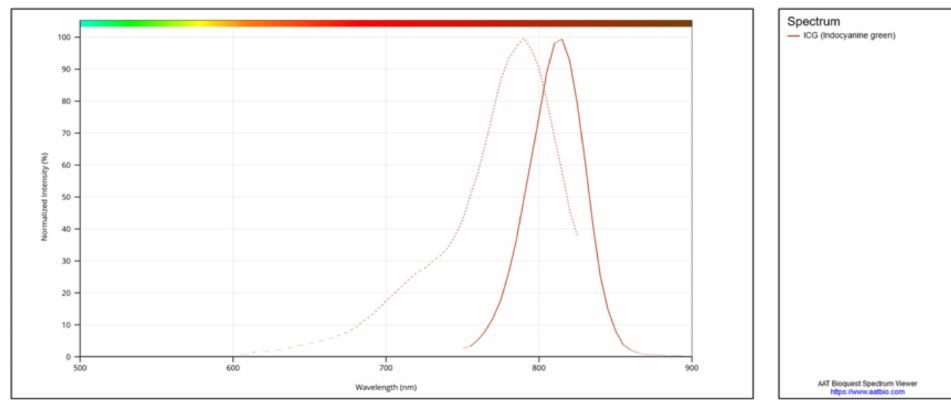
Figure 13. Excitation and emission spectrum of indocyanine green. Our device is based on Quest Spectrum ® , a medical device for fluorescence guided surgery from Quest Medical Imaging (Figure 14). The optical design of this device allows for the simultaneous acquisition of fluorescence images of two types of fluorophores methylene blue (MB) and ICG and the colour image for surgical guidance.